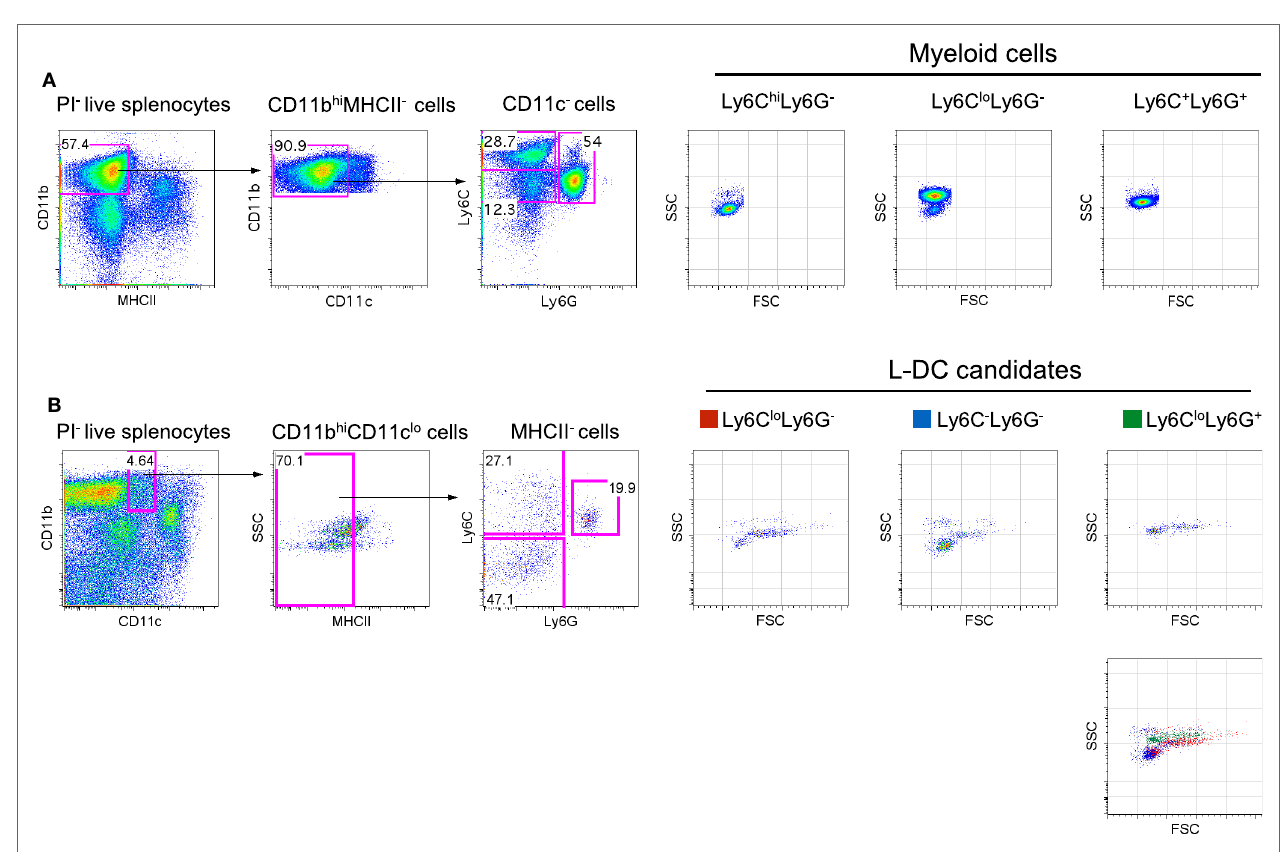
FigUre 1 | Phenotypic characterization of myeloid subsets in spleen . Spleen cells were depleted of T, B and red blood cells and stained with antibodies to CD11b, CD11c, MHCII, Ly6C, and Ly6G. Propidium iodide (PI, 1 μ g/mL) staining was used to gate live (PI − ) cells. (a) CD11b hi CD11c − MHCII − cells were initially gated on the basis of a blood monocyte phenotype. Further staining with Ly6C and Ly6G revealed three subpopulations with distinct FSC and SSC as reported in the literature (42). (B) L-DC were initially gated as CD11b hi CD11c lo MHCII − cells. Further staining with Ly6C and Ly6G revealed three populations of “L-DC candidates” with overlapping FSC and SSC profiles: Ly6C lo Ly6G + , Ly6C lo Ly6G − and Ly6C − Ly6G − . Gating strategies were based on fluorescence minus one control, and numbers in gates represent % specific